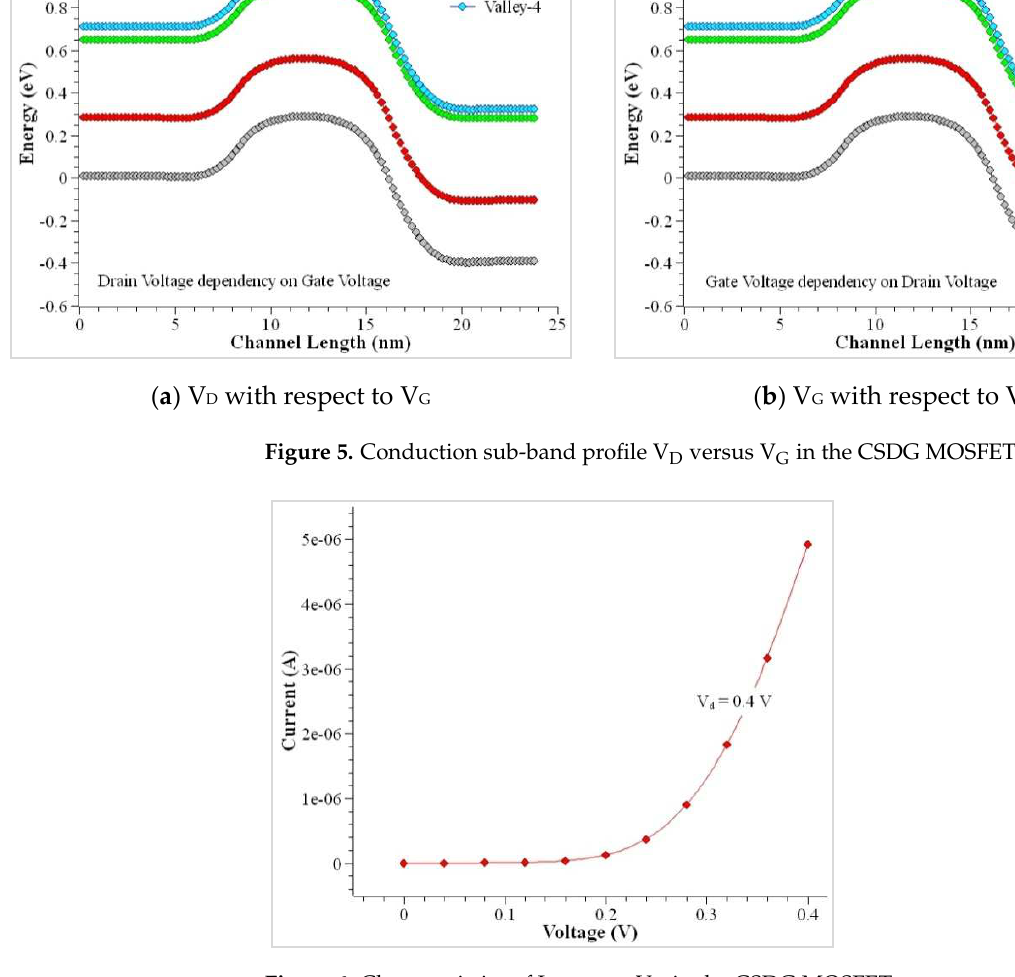
Figure 6. Characteristics of I D versus V G in the CSDG MOSFET.